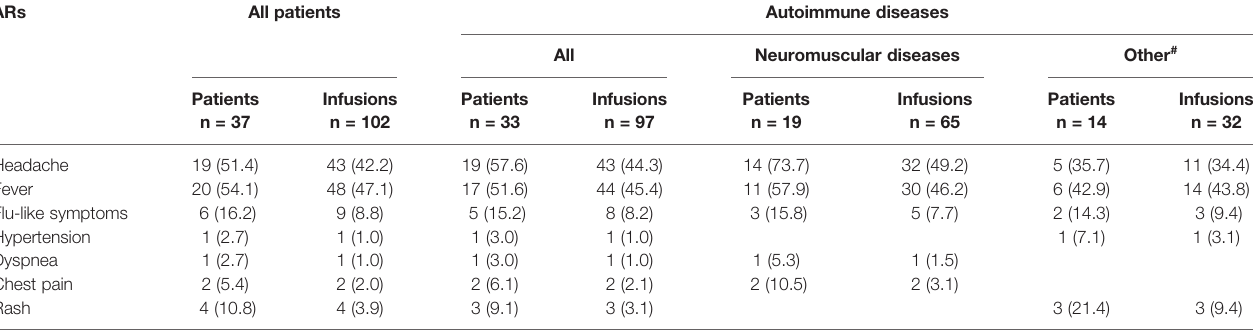
TABLE 6 | Clinical presentations of IVIG-related adverse reactions. ARs